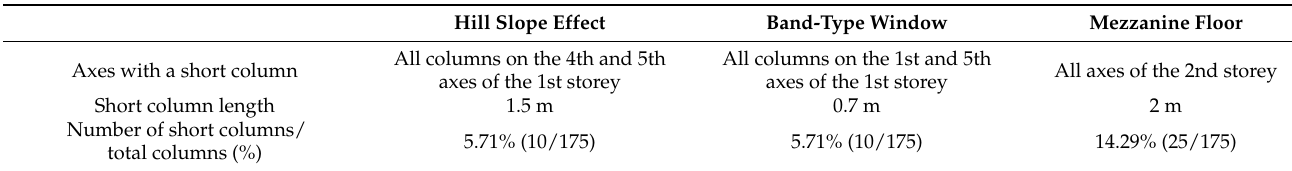
Table 2. Short columns length and their axes.